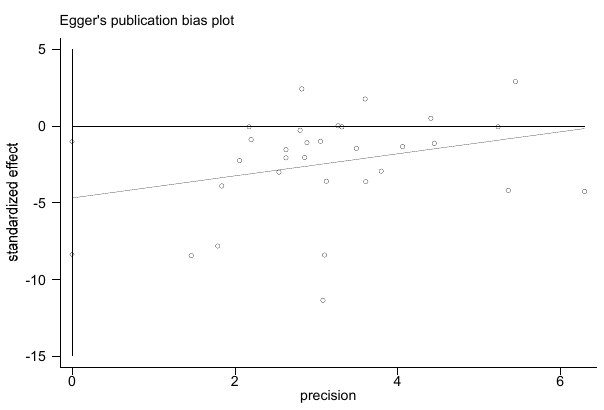
Figure 13. Egger’s test for evaluating the publication bias of TC.